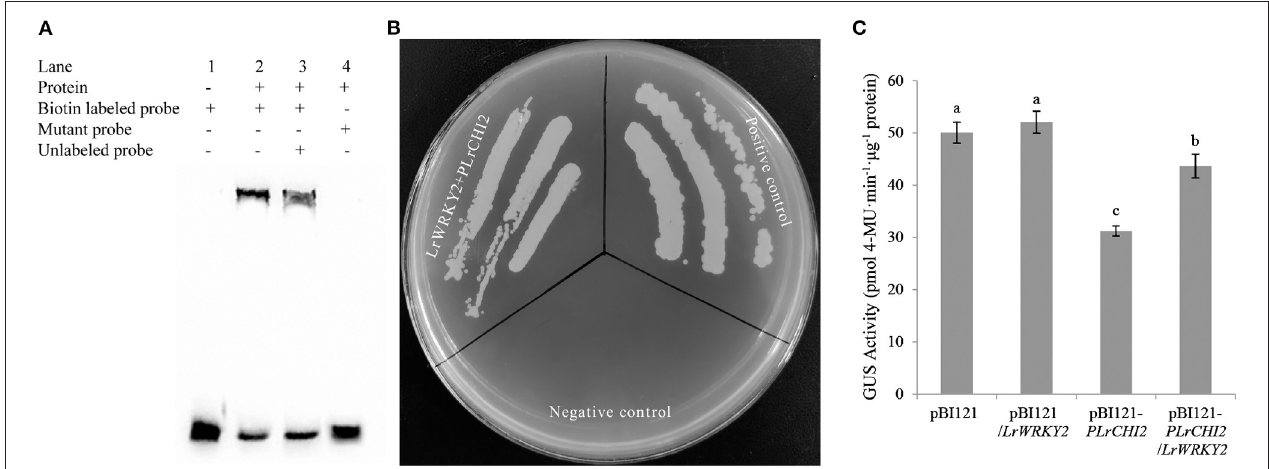
FIGURE 7 | Analysis of the interaction between LrWRKY2 and LrCHI2 promoter. (A) The specific binding of LrWRKY2 with the LrCHI2 promoter fragment was verified by EMSA. Line 1, the biotin labeled probes containing the W-box sequence. Line 2, LrWRKY2 can interact with the biotin labeled probes containing the W-box sequence 3, LrWRKY2 can interact with both the biotin labeled and unlabeled probes containing the W-box sequence. 4, LrWRKY1 can’t interact with mutant probes. (B) Analysis of the transactivation effect of LrWRKY2 recombinant protein on LrCHI2 promoter. LrWRKY2 + pLrCHI2, the interaction of pGADT7- LrWRKY2 and LrCHI2 promoter; Positive control, the interaction of pGADT7- p53 and pAbAi- p53 ; Negative control, the interaction of pAbAi- p53 and pGADT7 -LrWRKY2 . (C) GUS activity was higher in transgenic tobacco lines co-expressing of LrWRKY2 and LrCHI2 promoter than in the transgenic tobacco lines expressing of LrCHI2 promoter. Bars represent the standard errors of three biological replicates. The statistical differences were analyzed by Duncan’s multiple range test (Different letters indicate a significant